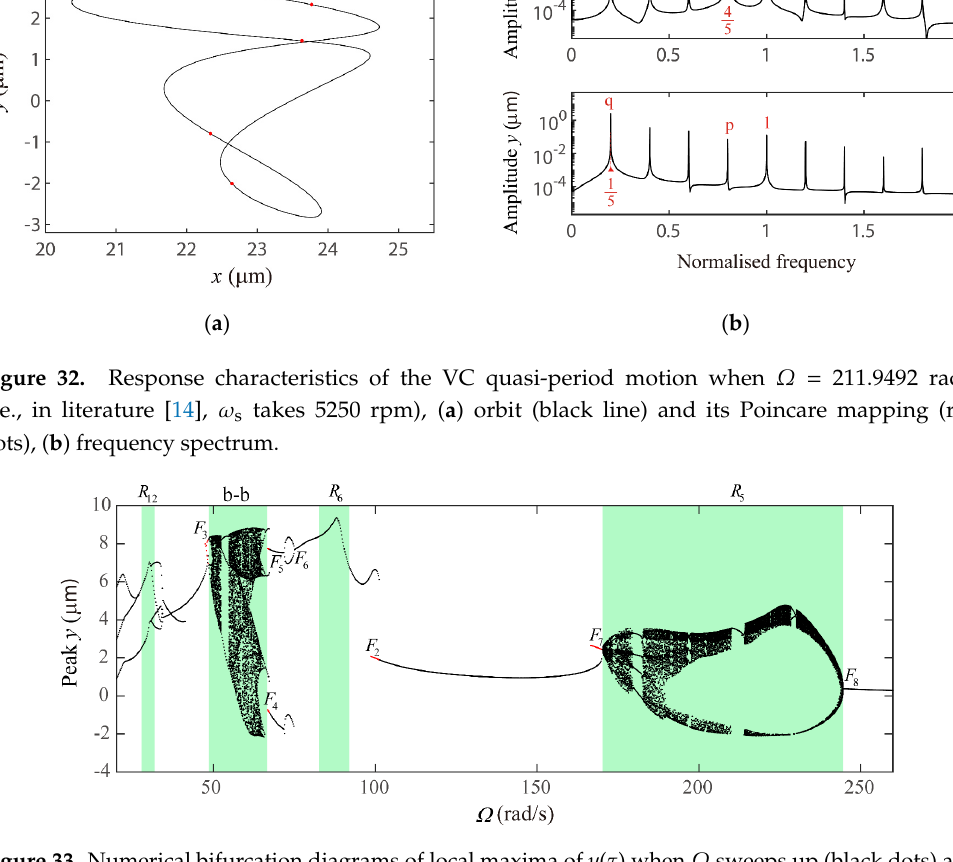
Figure 33. Numerical bifurcation diagrams of local maxima of y ( τ ) when Ω sweeps up (black dots) and down (red dots).